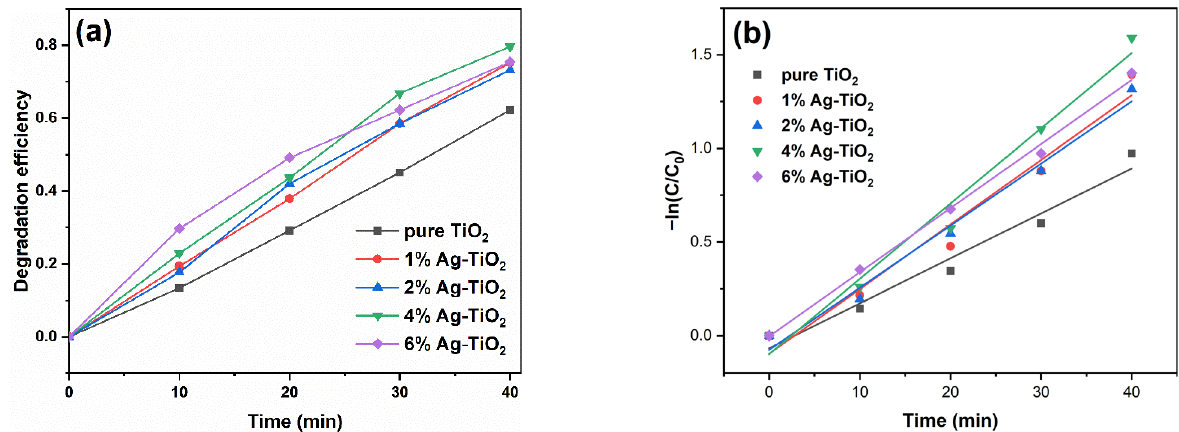
Figure 9. ( a ) Degradation degree curves and ( b ) kinetics curves of pure TiO 2 and Ag-TiO 2.